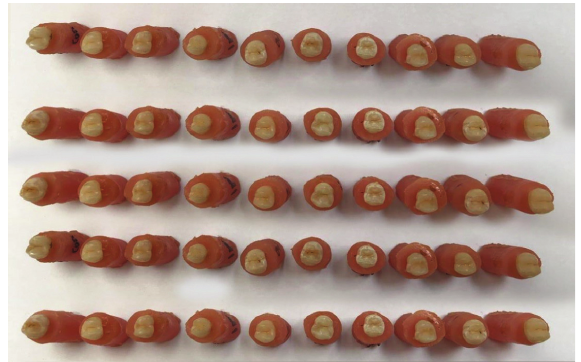
Figure 1: The prepared specimens of the study